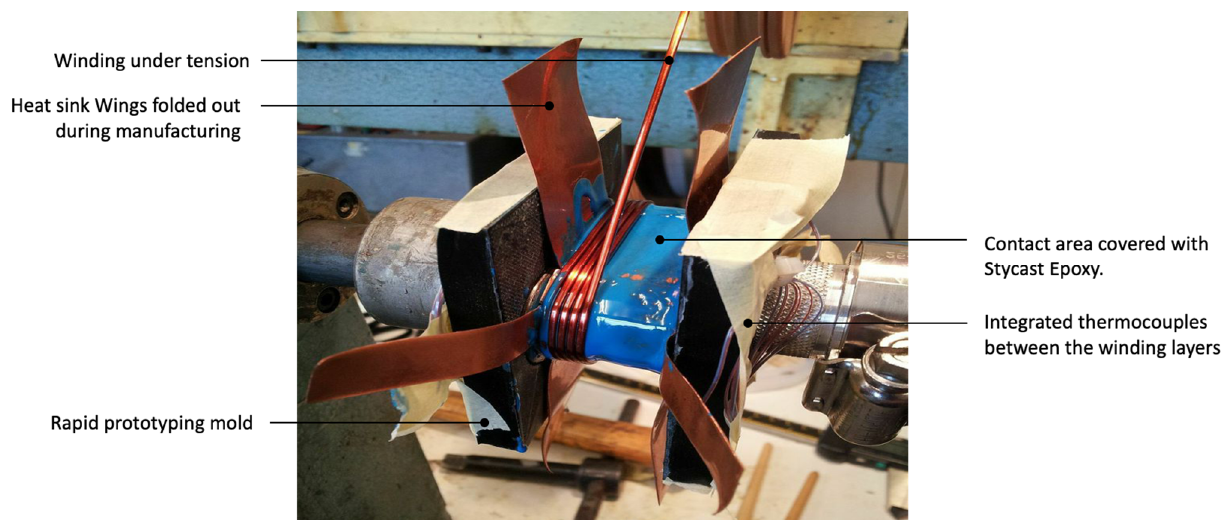
Figure 12. Details of the winding process with thermocouples mounted on the iron pole and between the winding layers.